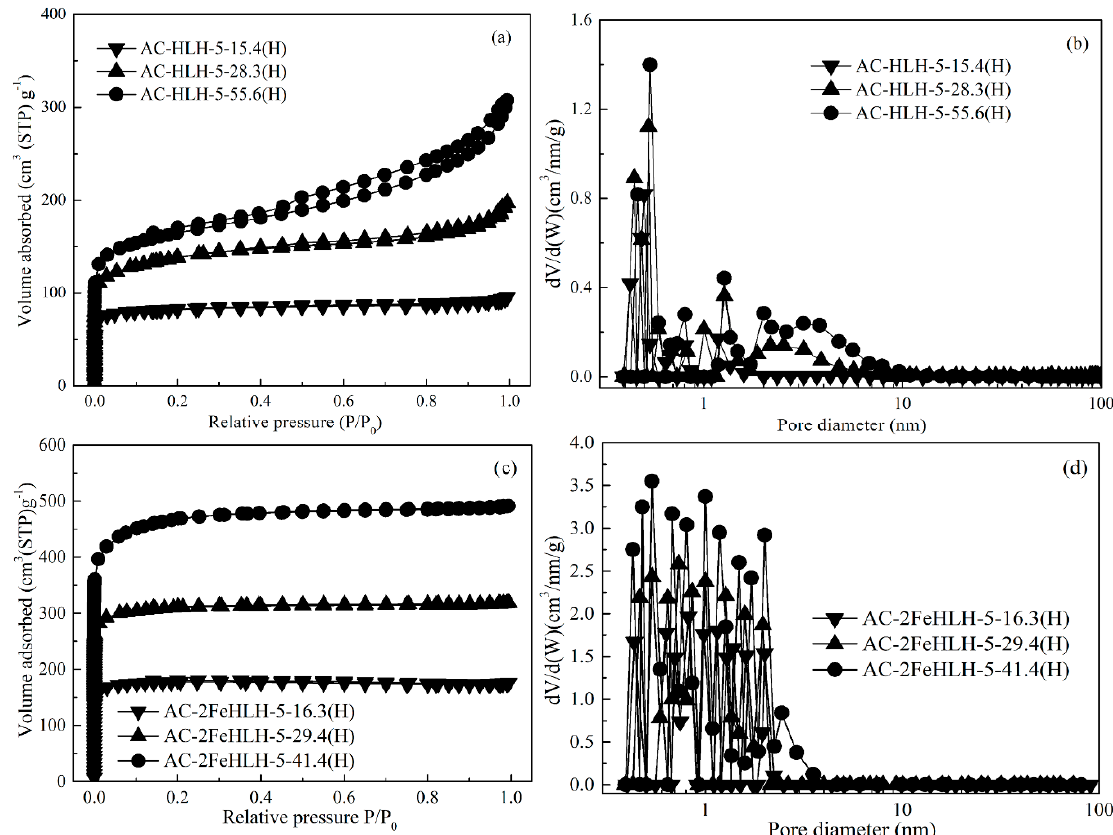
Figure 6. ( a ) N 2 adsorption isotherms and ( b ) pore-size distributions of AC-HLH-5 at different burn offs during activation; ( c ) N 2 adsorption isotherms and ( d ) pore-size distributions of AC-2FeHLH-5 at different burn offs during activation. Table 5. Pore structure parameters of typical chars at different burn offs during activation. Samples S BET (m 2 /g) V t (m 3 /g) V mic (m 3 /g) Non- V mic (%) AC-HLH-5-15.4(H) 103.63 0.062